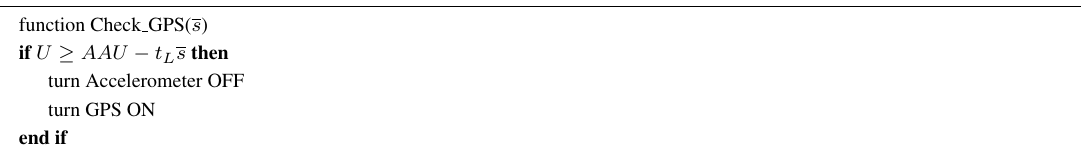
Figure 4. The Check GPS() function.